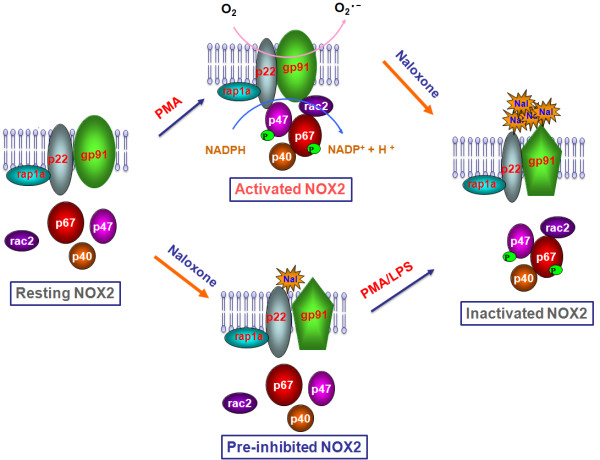
Summary of the potential mechanism of NOX2 inhibition by naloxone. Naloxone (Nal) inhibits activation of NOX2 and superoxide production by directly binding to the gp91phox-p22phox complex, and then preventing the translocation of cytosolic subunits. It is interesting to note that the binding capacity of 3H-naloxone to the gp91phox-p22phox complex was greatly enhanced after activation of NOX2. Binding of naloxone to the gp91phox-p22phox complex may change the conformation of the protein complex and subsequently decrease the affinity of binding of the cytosolic subunits (p47phox, p67phox).